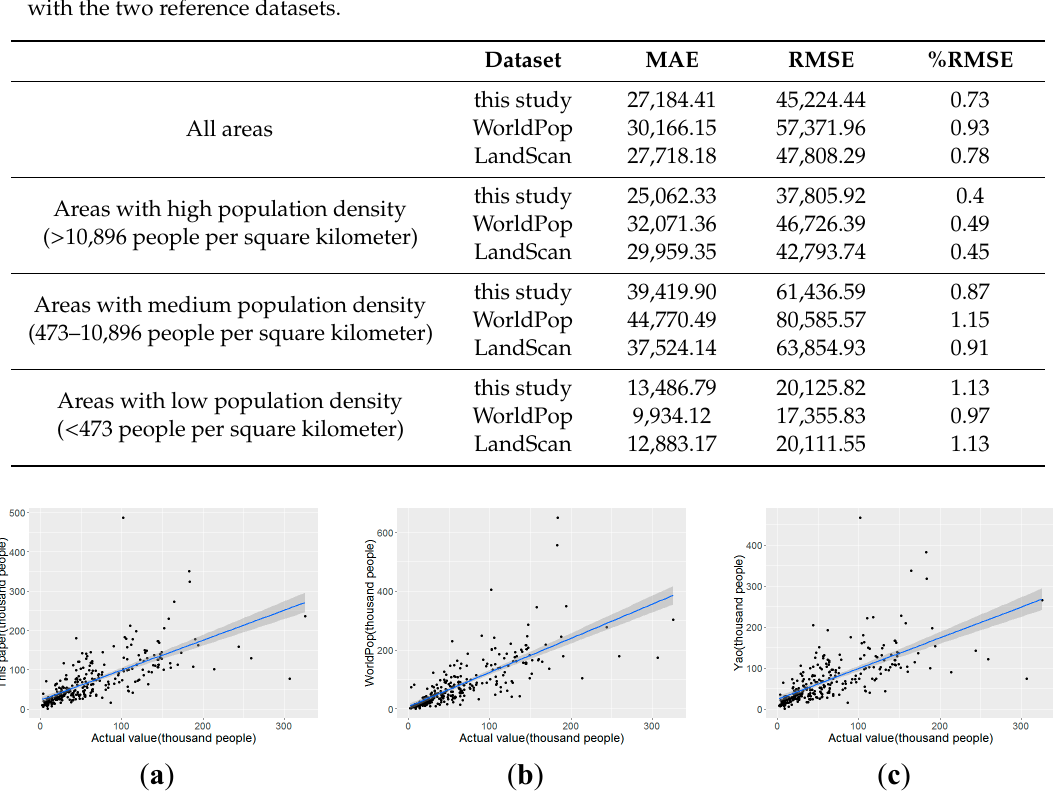
Figure 12. Scatter plots of results in this study and existing datasets. ( a ) Result of the PSP-driven dasymetric model, ( b ) the WorldPop dataset, and ( c ) the LandScan dataset.